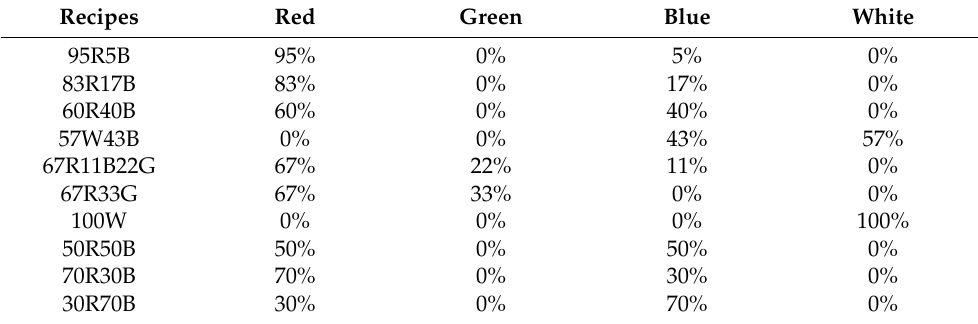
Table 1. Light treatments (recipes) for the first dataset (Test 1).